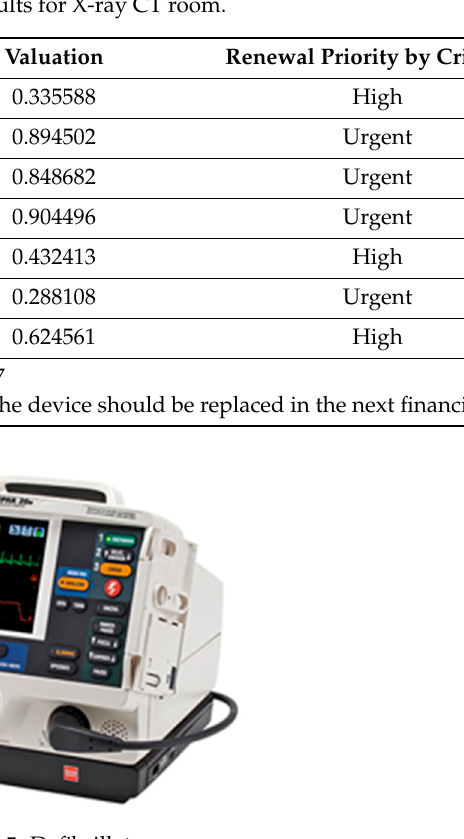
Figure 5. Defibrillator.